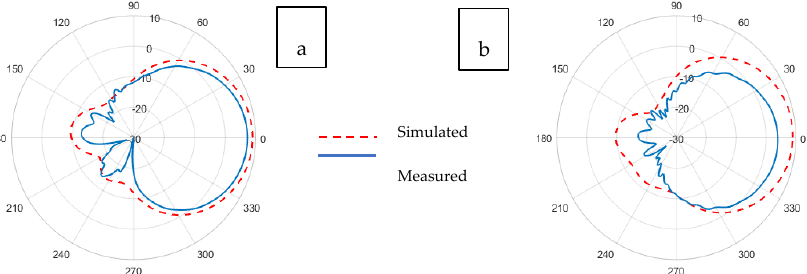
Figure 13. Simulated and experimental ( a ) E-plane and ( b ) H-plane radiation patterns of Kiel-SK-96-based non-perforated RRMPA at 2.45 GHz.